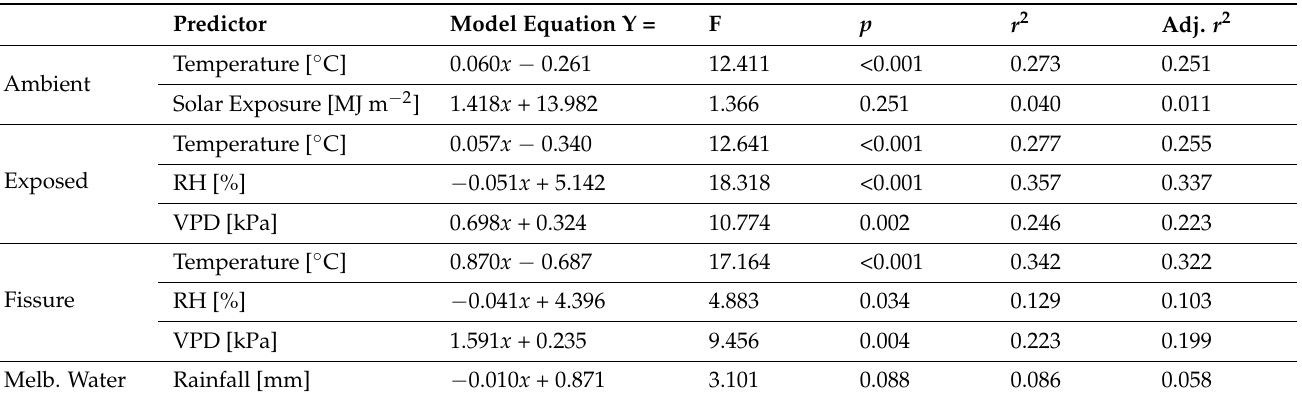
Table A9. Summary of climate regression models predicting Marchalina hellenica density. Climate records used in models represent the fortnightly mean value of daily maximum, except rainfall; recorded cumulatively in millimetres. N = 34 for each regression analyses.